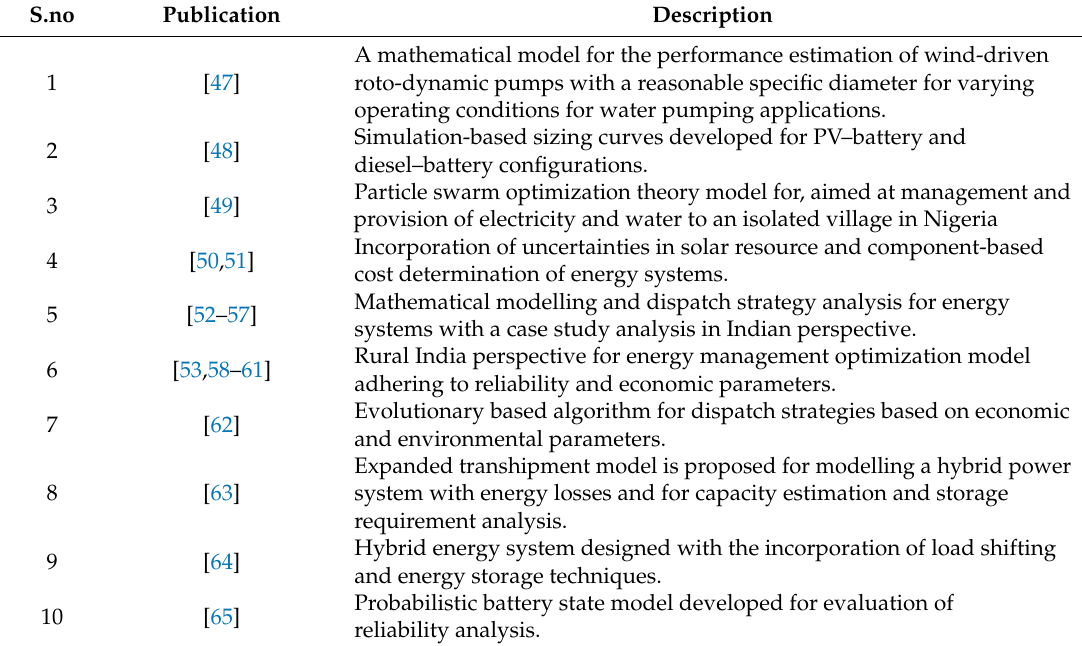
Table 3. Microgrid models and simulation methodologies (stand-alone and